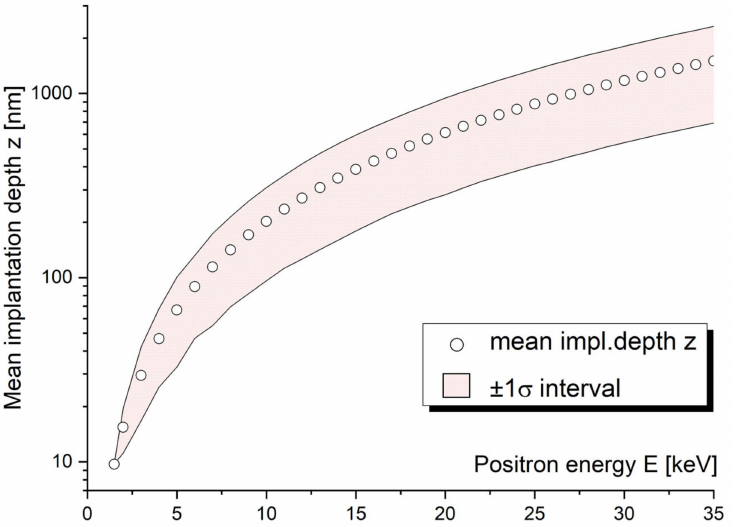
Figure 3. Mean implantation depth of positrons with variable energy (E). The standard deviation was calculated from the Gaussian-like Makhovian function as FWHM half of the maximum